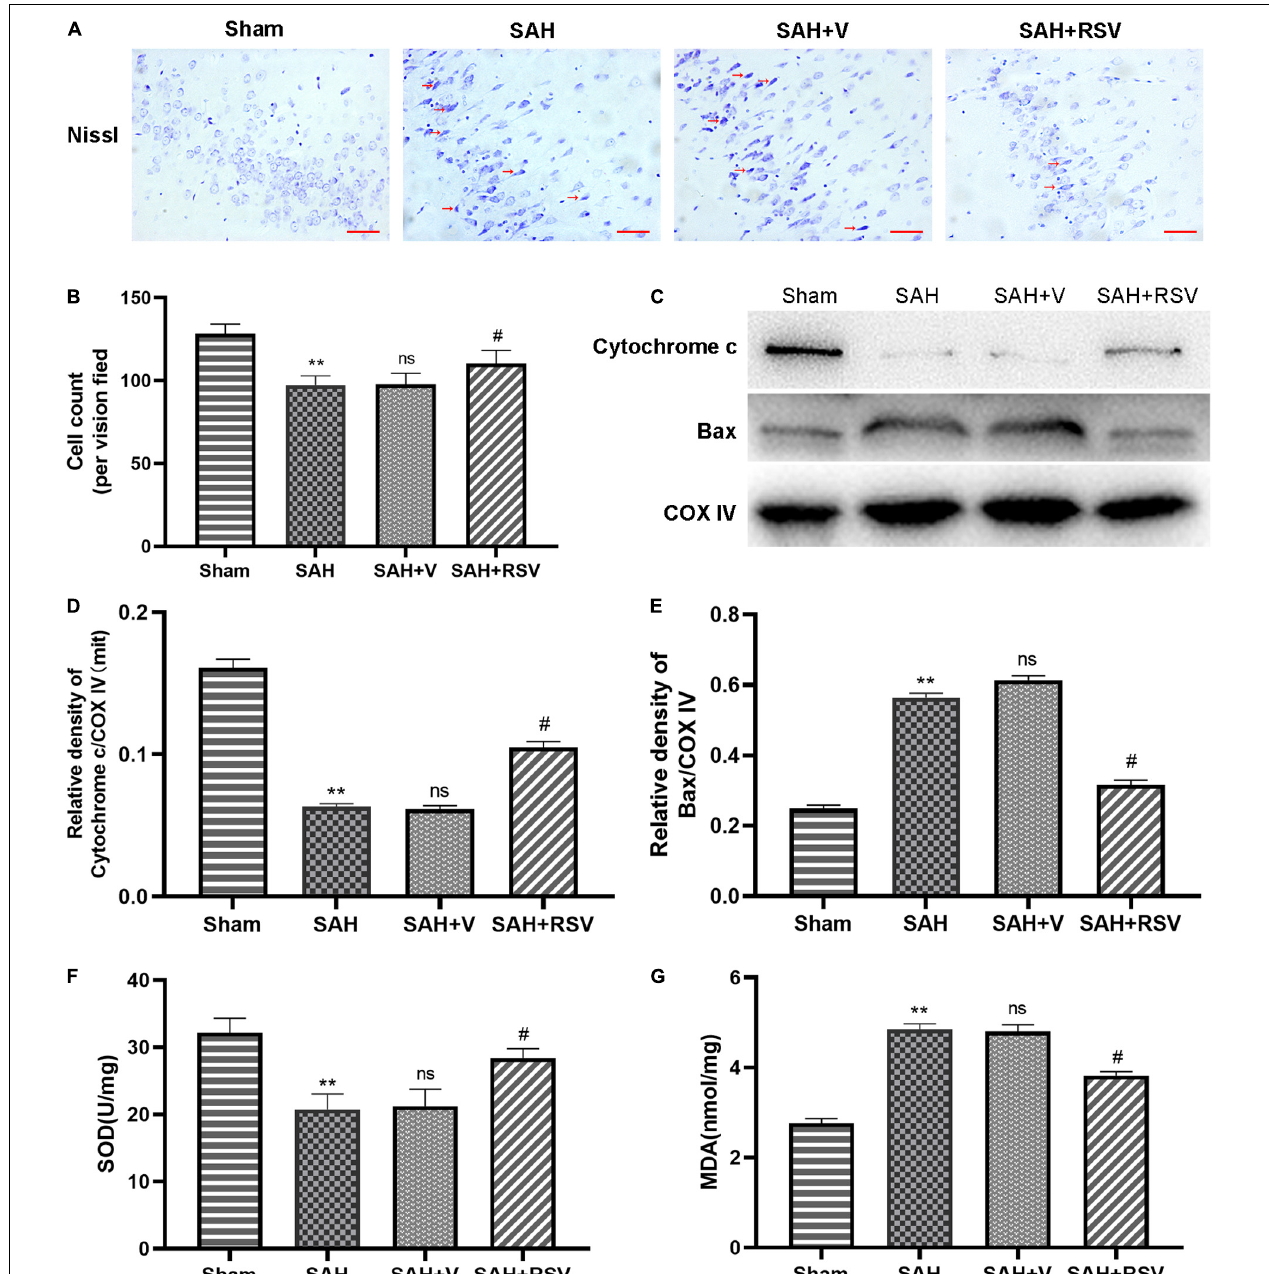
FIGURE 3 | Effect of RSV on mitochondrial function was determined 24 h following SAH. (A,B) Representative images of Nissl staining in the temporal cortex showed that RSV could evidently reduce the number of surviving neurons. Arrows point to dead neurons. (C) The expression of mitochondrial Bax and cytochrome C in the temporal cortex was detected by Western blot 24 h after SAH. Representative images showed that the relative expression of mitochondrial Bax was decreased, while cytochrome c was restored after RSV administration. Relative protein levels were standardized with respect to COX IV protein (D,E) . (F,G) The levels of mitochondrial MDA in the temporal cortex were significantly obviously attenuated, and the activities of mitochondrial SOD were significantly increased by RSV treatment. Data were represented as mean ± SEM ( n = 6). ** p < 0.01 vs. sham group; ns p > 0.05 vs. group with SAH; # p < 0.05 vs. vehicle-treated